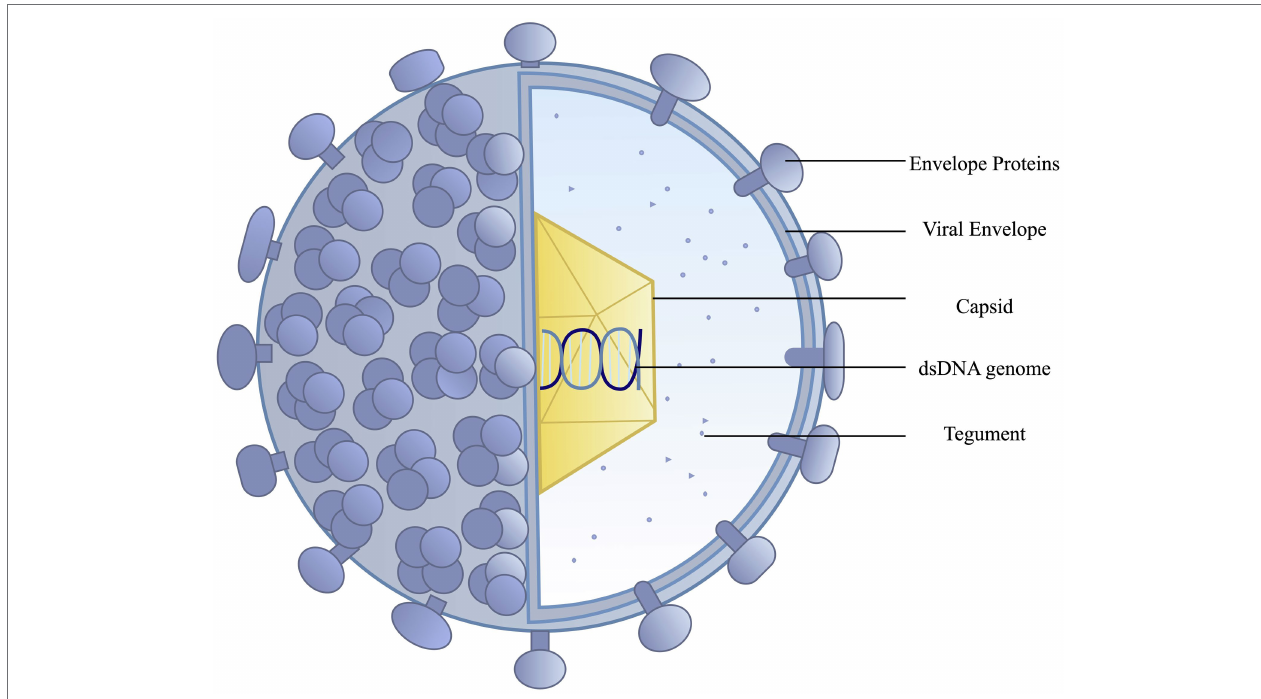
FIGURE 1 | Herpes simplex viruses have an outer lipid bilayer envelope with an inner icosahedral capsid. Mature virions contain an amorphous layer of proteins, the tegument, outside the nucleocapsid. The lipid bilayer envelope, derived from the host cell membrane, contains a range of viral